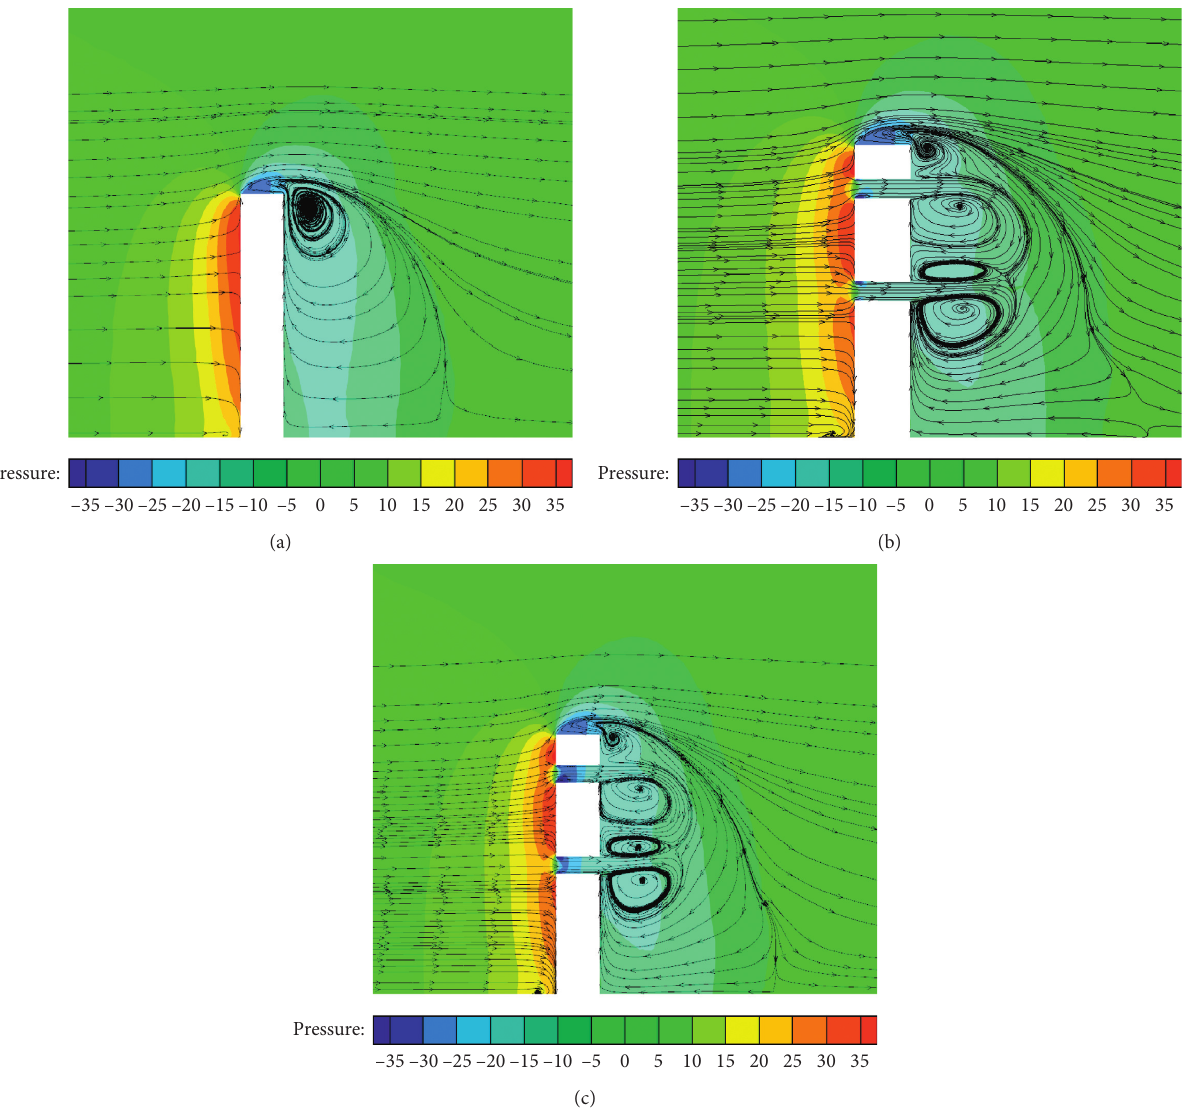
Figure 8: Mean wind pressure distributions on windward and leeward faces at different elevations. (a) L-1 model. (b) L-2 model. (c) L-3